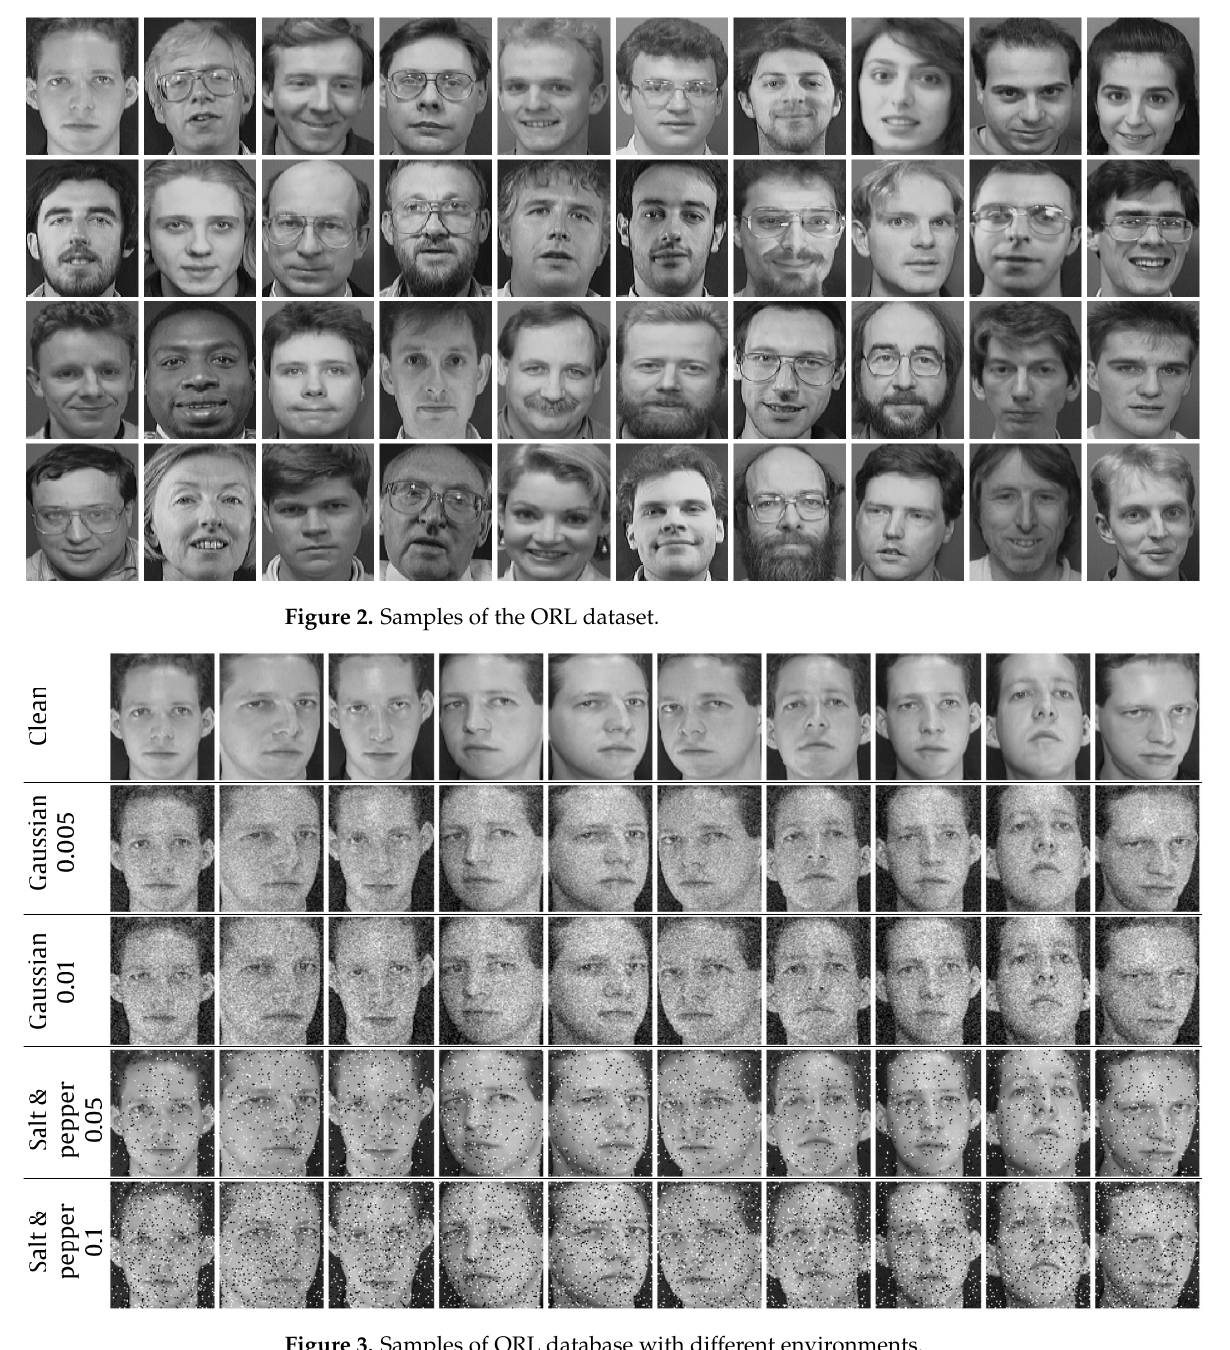
Figure 3. Samples of ORL database with different